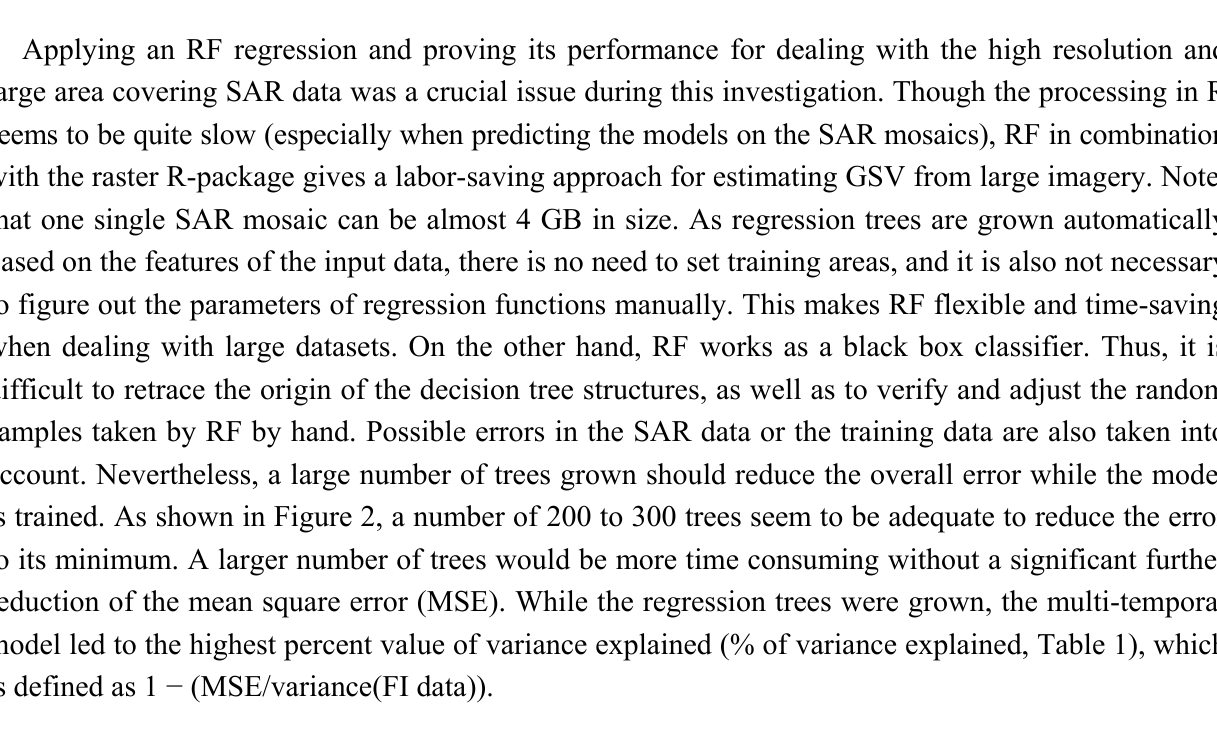
Figure 2. Relationship between the number of trees grown and the reduction of the MSE during model generation in the case of the multi-temporal RF model.